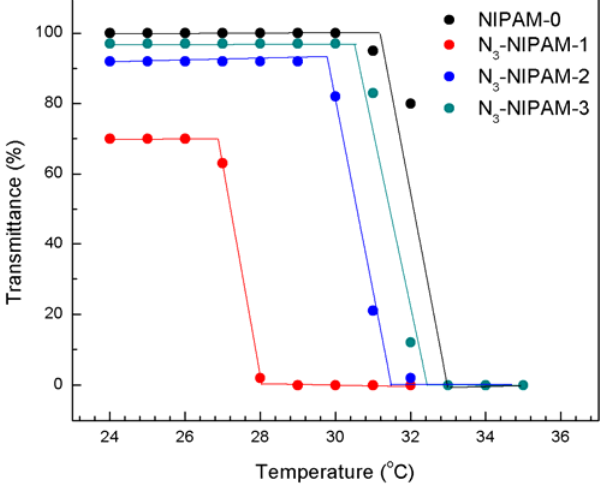
Figure 4. Variation of transmittance with temperature for the series of N PNIPAM-0 water solution (2